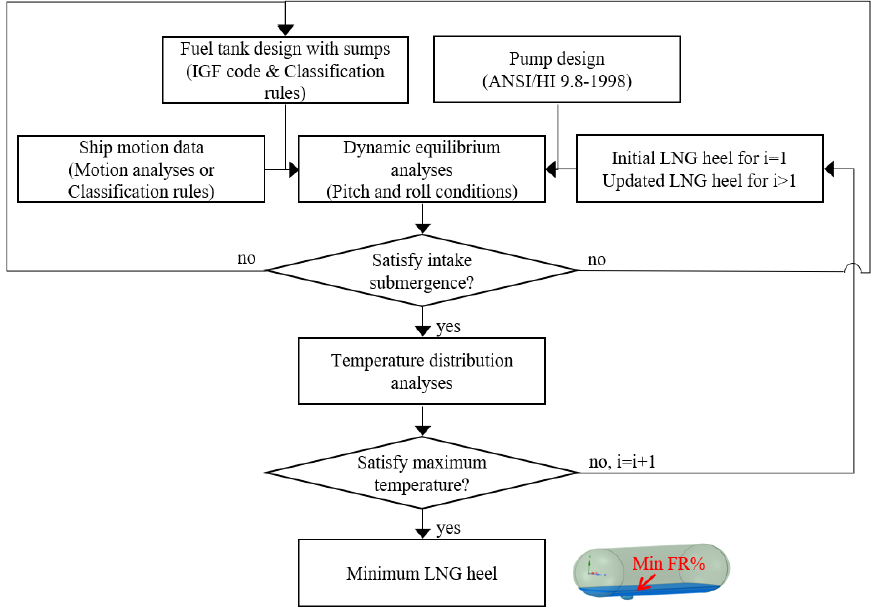
Figure 1. Flow chart of tank heel determination.